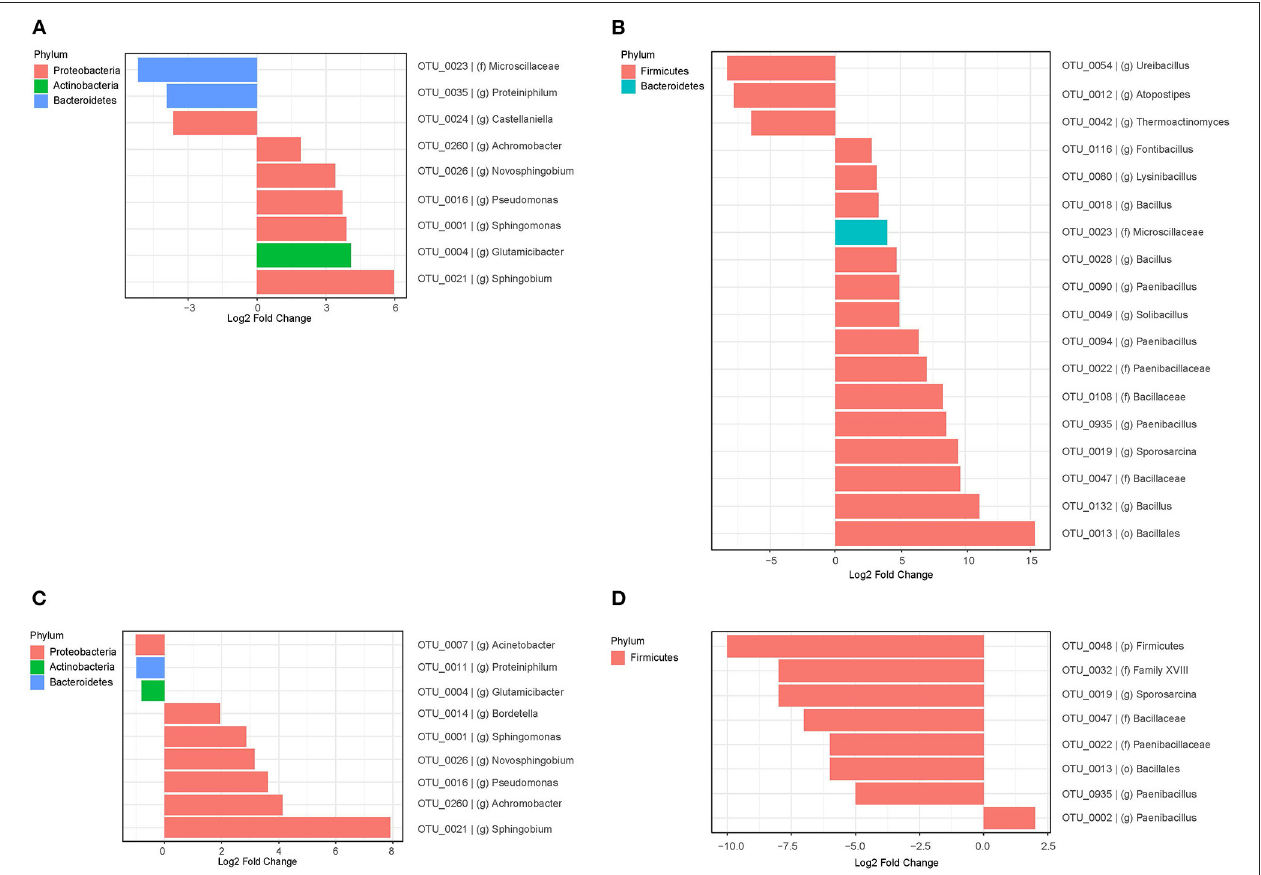
FIGURE 2 | Differential analysis of OTUs whose relative abundance changed significantly after 5 days of cultivation as compared to the start of the experiment. (A,B) Show the results from bacterial communities in the 1st enrichments of T1 and T4A soil, respectively, and (C,D) those from bacterial communities in the 2nd enrichments of T1 and T4A soil, respectively. The phyla of the respective OTUs are indicated at the upper left of each figure with the corresponding